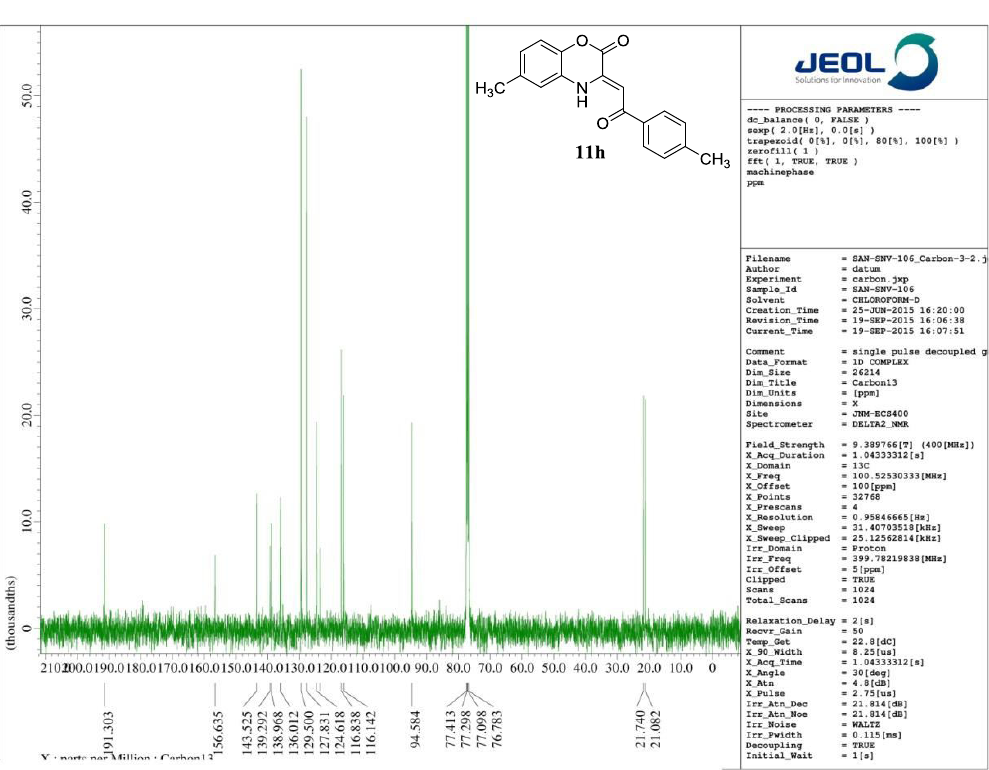
Figure 16. 13 C NMR Spectra of Compound 11h